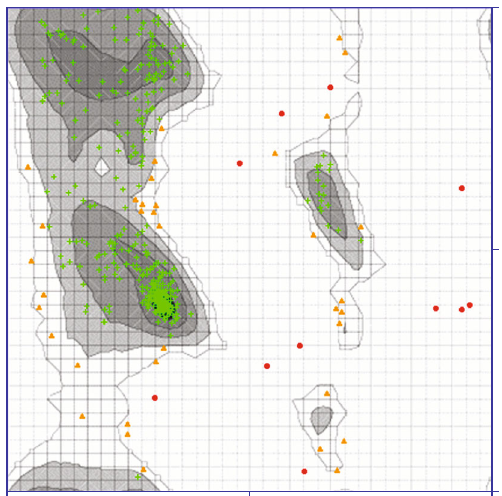
Figure 1: The Ramachandran plot of evaluation 3D structure was modeled using ZLab server; green: highly preferred conformations, delta ≥ − 2 ; brown: preferred conformations, − 2 > delta ≥ − 4 ; and red: questionable conformations, delta < − 4